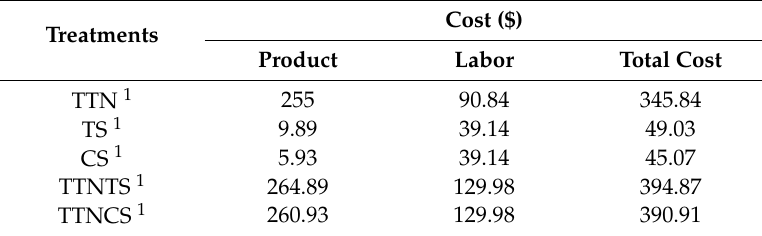
Table 4. Cost of control methods (TTN, TS, CS, TTNTS, and TTNCS) per hectare per